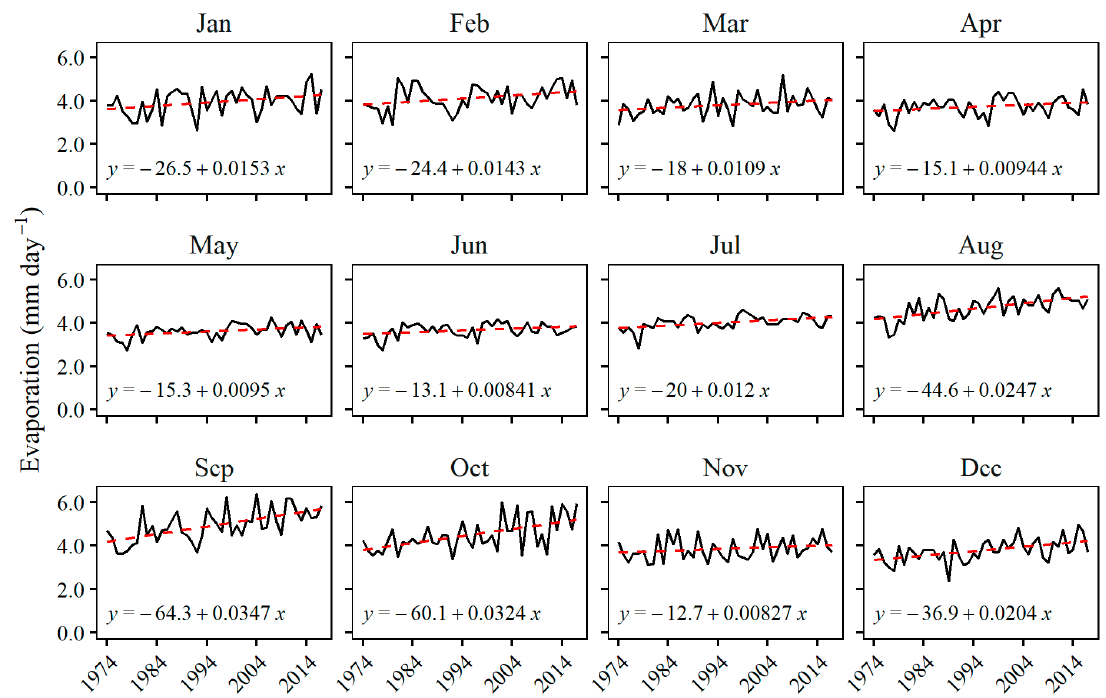
Figure 8. Average monthly evaporation estimated by the average of the best performing methods (KNF: Kohler et al. (1955) and L93: Linacre (1993)) based on the historical series and trend line (dashed